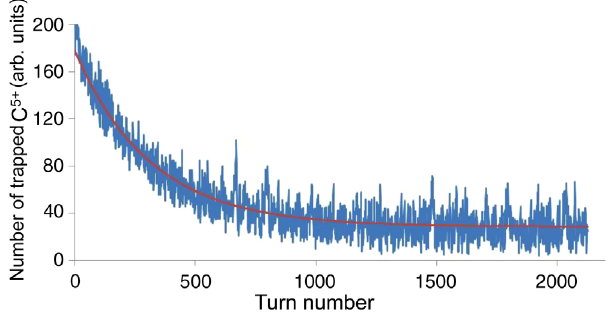
FIG. 16. Beam survival of C 5 þ